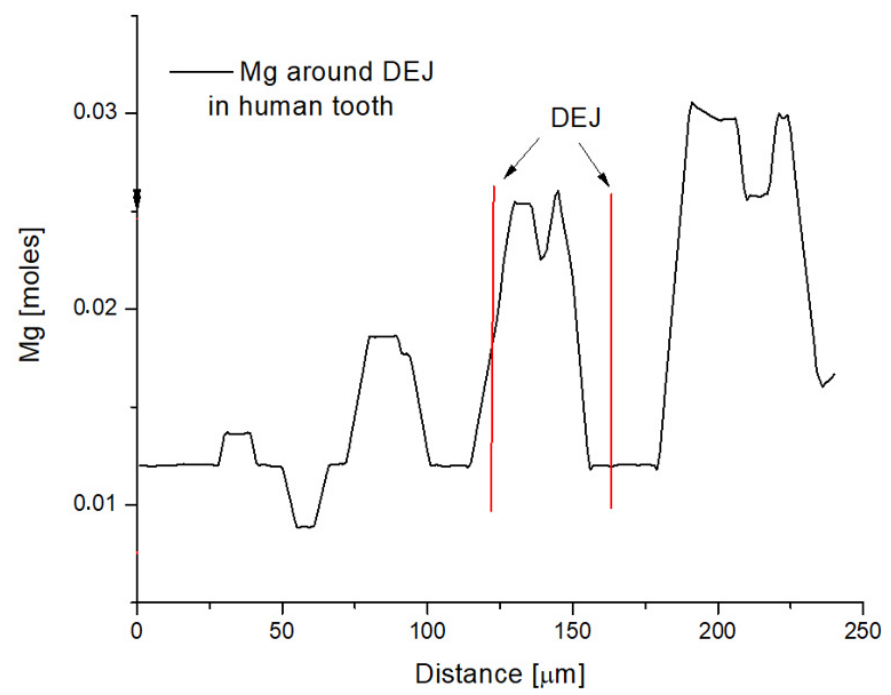
Figure 2. Oscillation of Mg around DEJ in human molar teeth.